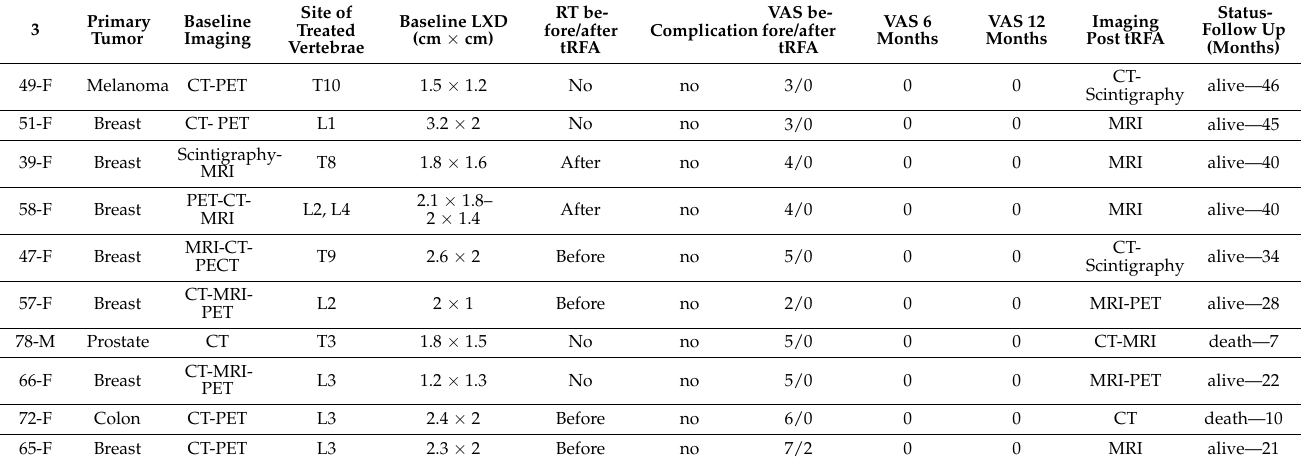
Table 2. Group A (patients with one or two vertebral metastatic